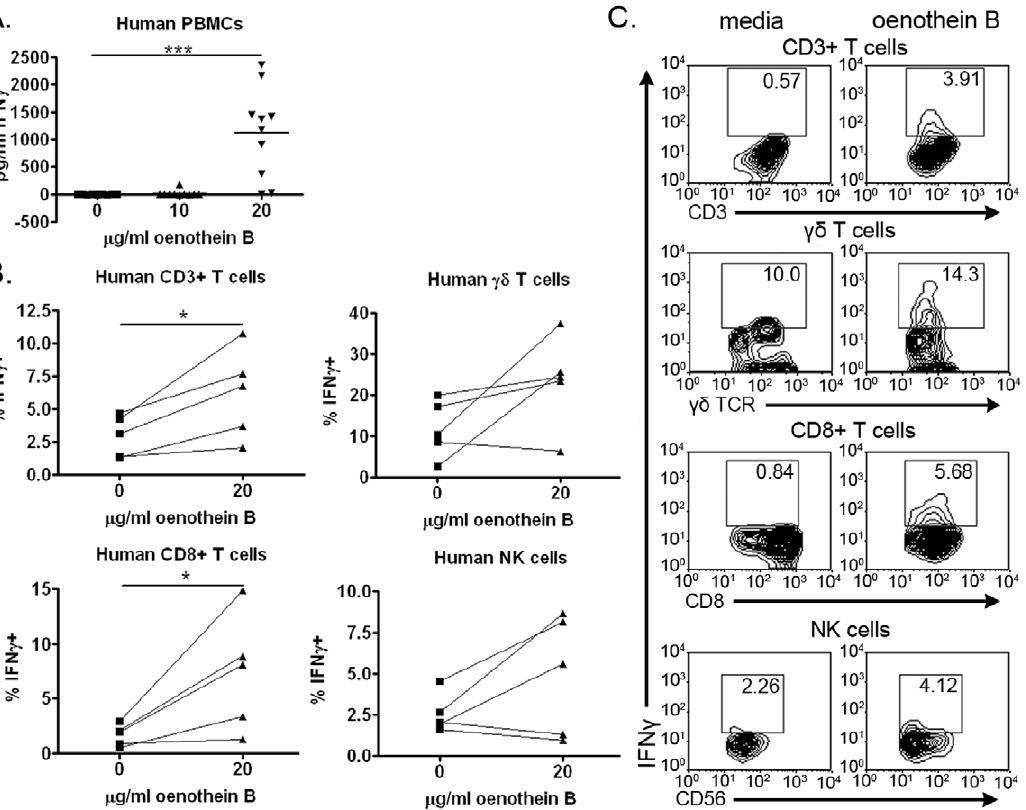
Figure 5. IFN c production by human lymphocytes in response to oenothein B. (A) Human PBMCs (10 5 cells/well) were treated with the indicated concentrations of oenothein B or X-VIVO medium alone for 48 hrs, and soluble IFN c levels in supernatant fluids were measured by ELISA. The graph represents data from ten individuals, with each sample plated in triplicate. Statistical significance was measured by One-way ANOVA with Bonferroni post-test. *p , 0.05, **p , 0.01, ***p , 0.001 (B) Human PBMCs (10 5 cells/well) were treated with oenothein B or X-VIVO medium alone for 6 hrs in the presence of brefeldin A. The percent of total CD3 + T cells, cd T cells, CD8 + T cells, and NK cells positive for IFN c staining was then determined by flow cytometry. The graphs represent data for five individuals, with each treatment analyzed in triplicate. Statistical significance was determined by paired Student’s t-test. *p , 0.05, **p , 0.01, ***p , 0.001 (C) Representative examples of two-color flow cytometry plots comparing IFN c staining on oenothein B-treated and untreated human